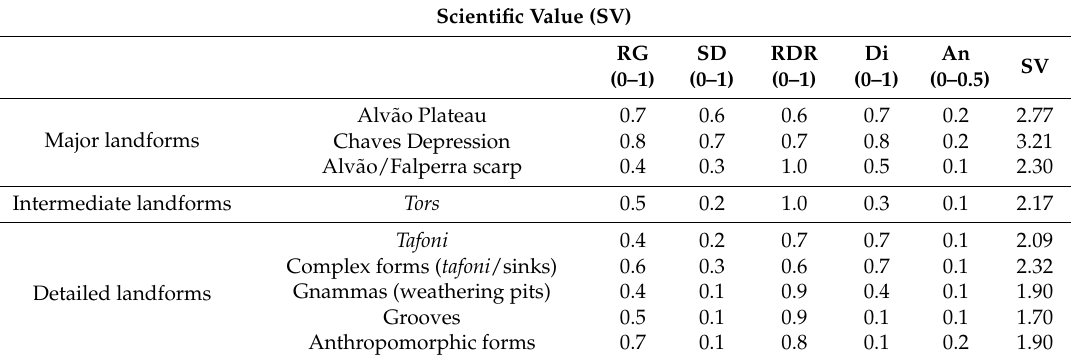
Table 1. Scientific value (SV) of geomorphosites.